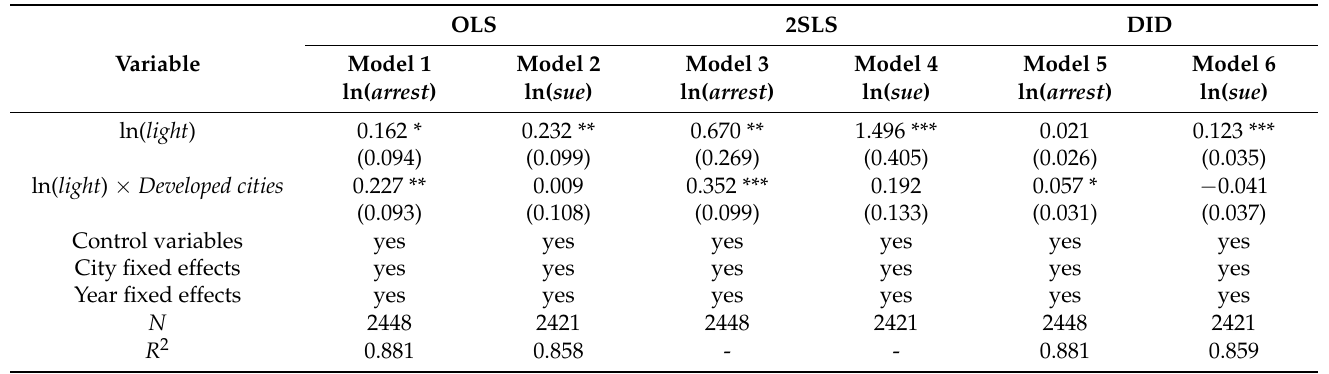
Table 6. Regression results based on the economic development level.